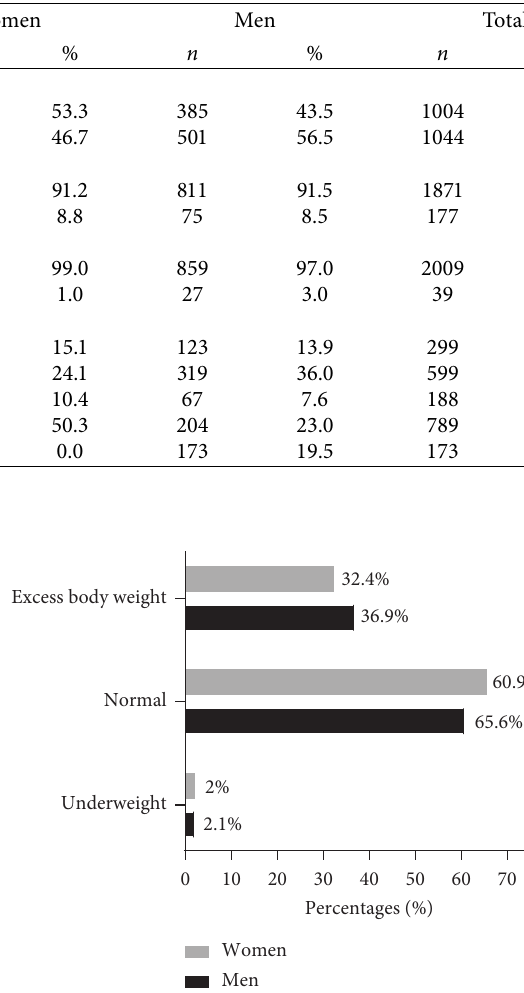
Figure 2: Distribution of the descriptive characteristics of the BMI according to the sex of the students. Note . p � 0 . 097, chi-square was used to compare the proportions between women and men. Underweight (BMI < 18.5kg/m 2 ), normal (BMI 18.5–24.9 kg/m 2 ), and excess body weight (BMI ≥ 25).